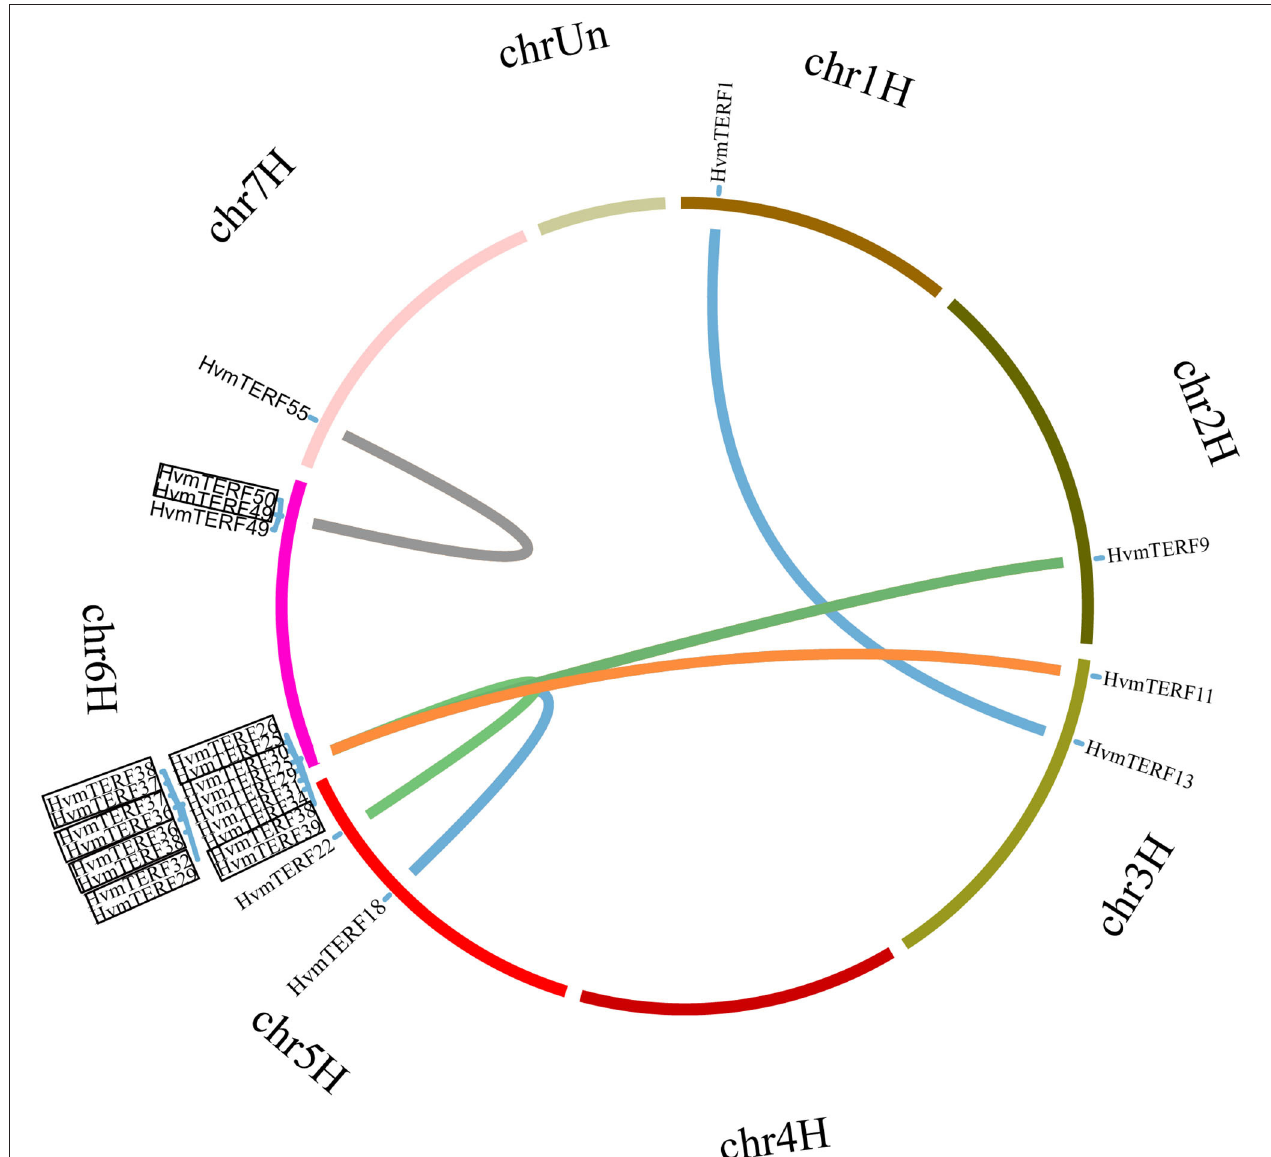
FIGURE 3 | Chromosomal location and gene duplication of HvmTERF s. Tandemly duplicated gene pairs are highlighted with black